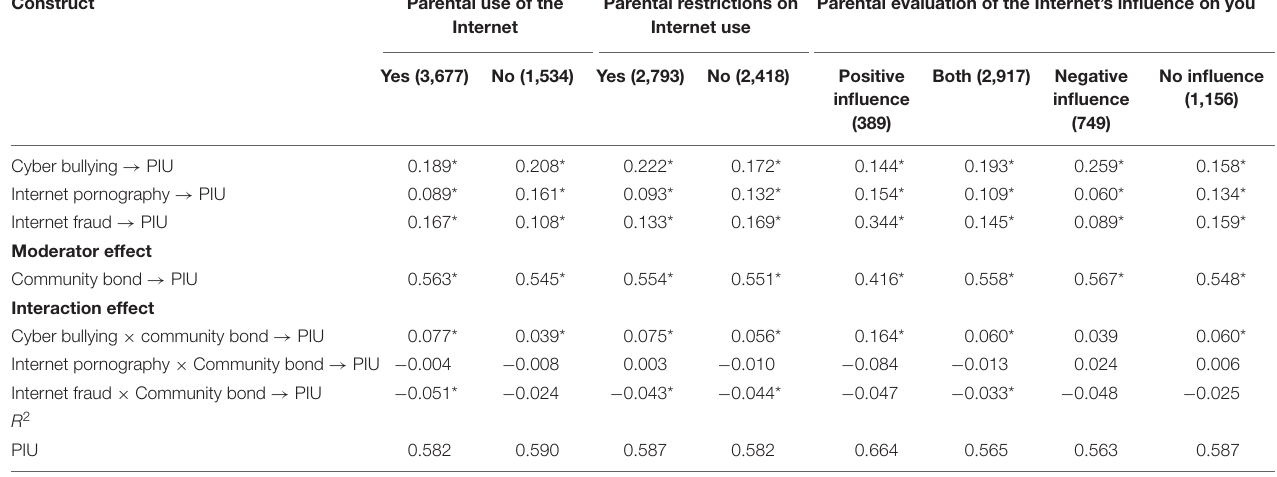
TABLE 4 | Structural equation modeling (SEM) analysis